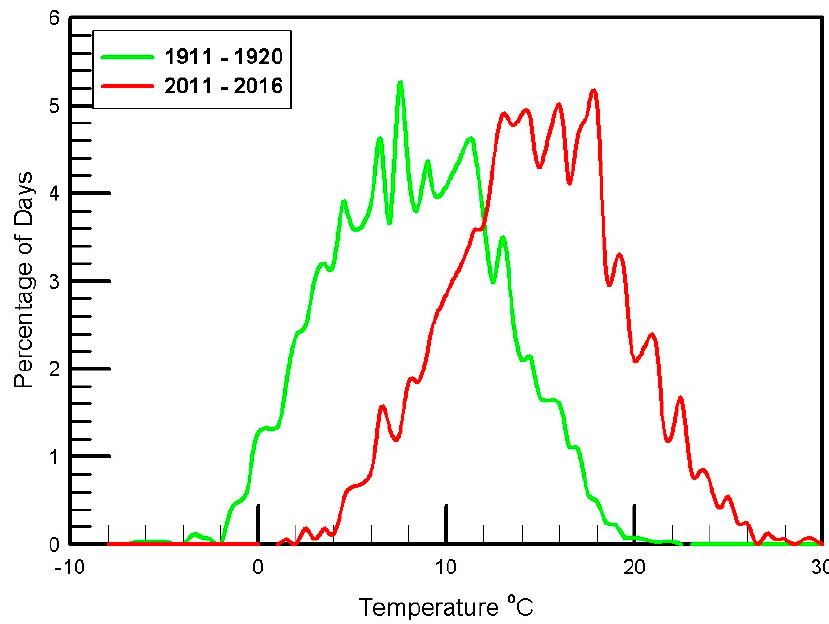
Figure 5. Nighttime temperatures in Pasadena by decade, 1911–2016.